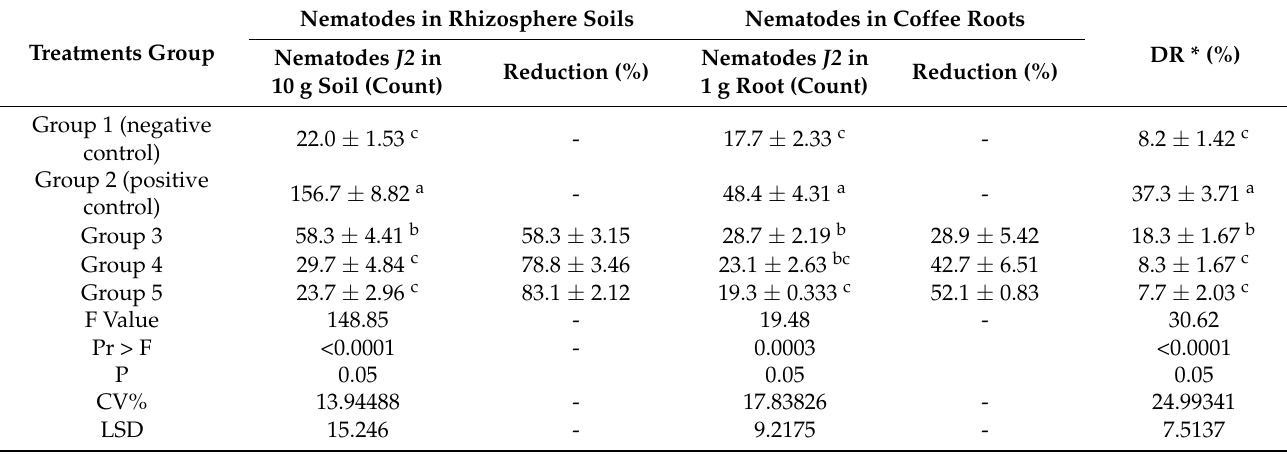
Table 2. The effect of Pseudomonas aeruginosa TUN03 on the density of coffee nematodes in soils and coffee roots and the death rate of coffee seedlings cultivated under greenhouse conditions.